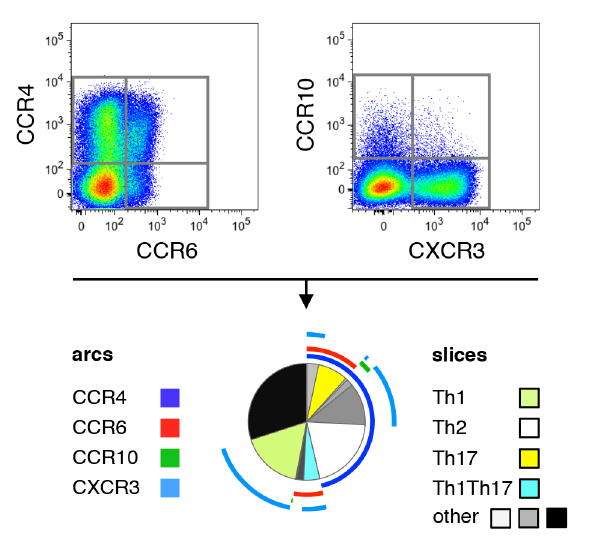
Supplementary Figure 3. Chemokine receptor staining and definition of Th subsets. Gates for the expression of CCR4, CCR6, CCR10, and CXCR3 were defined within total CD4 + T cells. Th subsets were identified by the resulting co-expression pattern, following the gating scheme published in